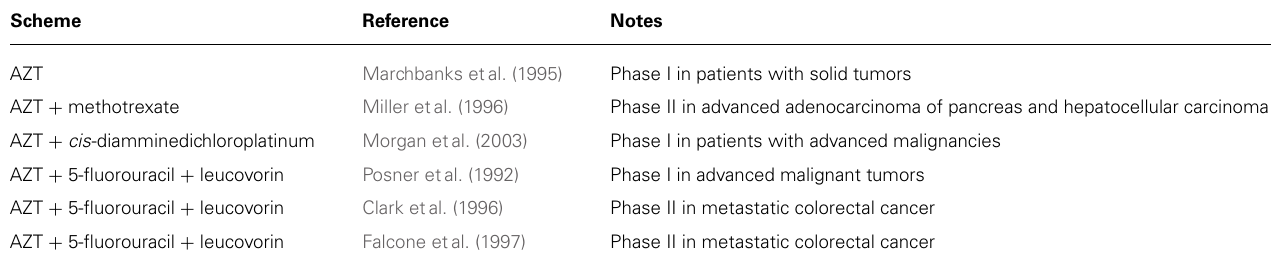
Table 1 | Cancer clinical trials